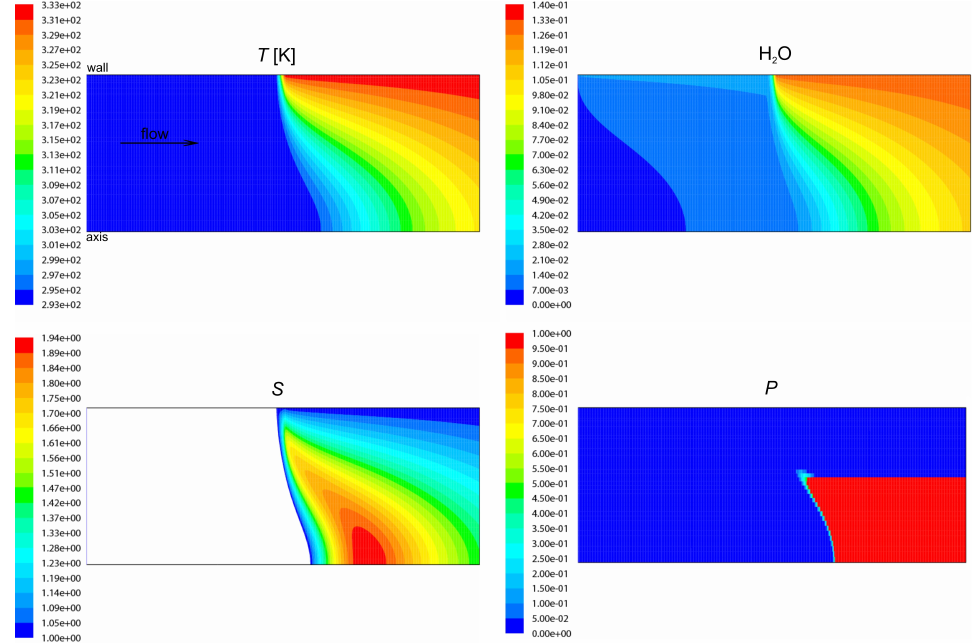
Fig. 2. Contours of temperature (upper left panel, T [K]), water vapour mass fraction (upper right panel, H 2 O), water vapour saturation ratio (lower left panel, S) , and heterogeneous nucleation probability for 6nm seed particles (lower right panel, P) inside the TSI 3785 WCPC with a saturator temperature T s =20 ◦ C and growth tube temperature T gt =60 ◦ C.